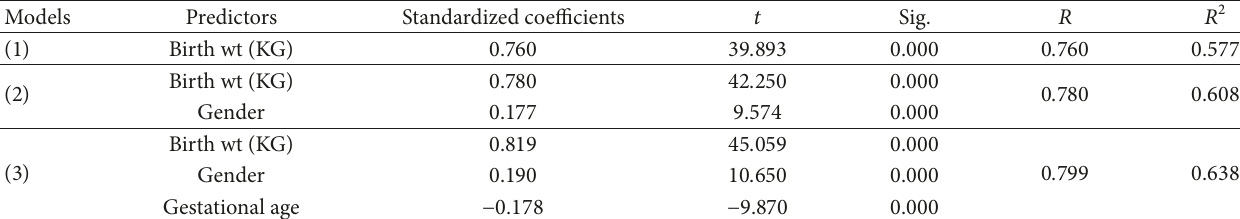
Table 8: Stepwise regression of predictors of skinfold